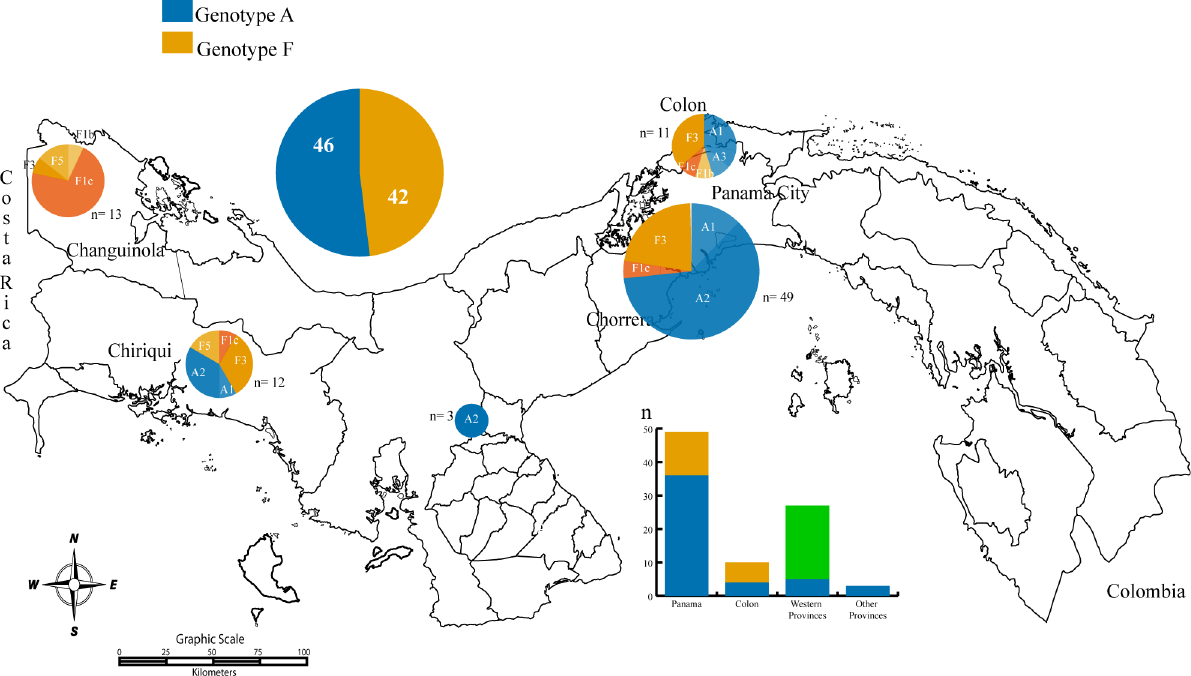
Fig 2. Map of Panama indicating the origin of the HBV sequences analyzed in this study. The number of sequences according to the genotype is indicated in the top left pie chart, the middle bar plot indicates the number of genotypes according to geographic area. Pie charts within the map are sized by the proportion of sub-genotype found in the corresponding region.